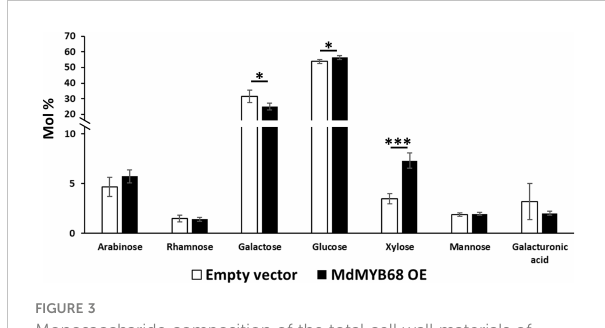
FIGURE 3 Monosaccharide composition of the total cell wall materials of control (white bars) and MdMYB68 -overexpressing N. benthamiana leaves (black bars) collected 7 days after in fi ltration. Values are expressed as the mean ± standard deviation (SD) from four independent biological replicates. One and three asterisks indicate signi fi cant differences at p < 0.05 and p < 0.001,